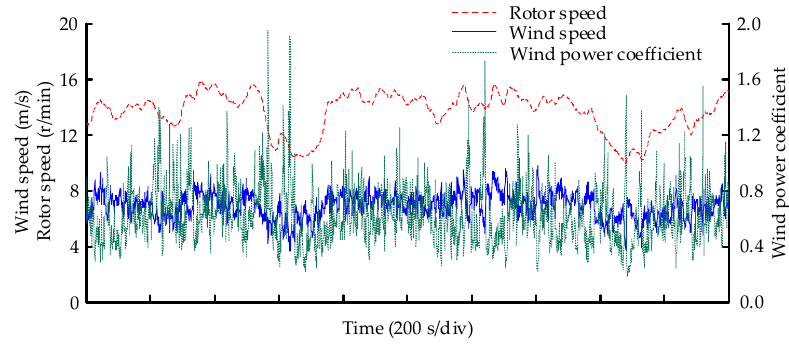
Figure 5. Directly calculated wind power coefficient.